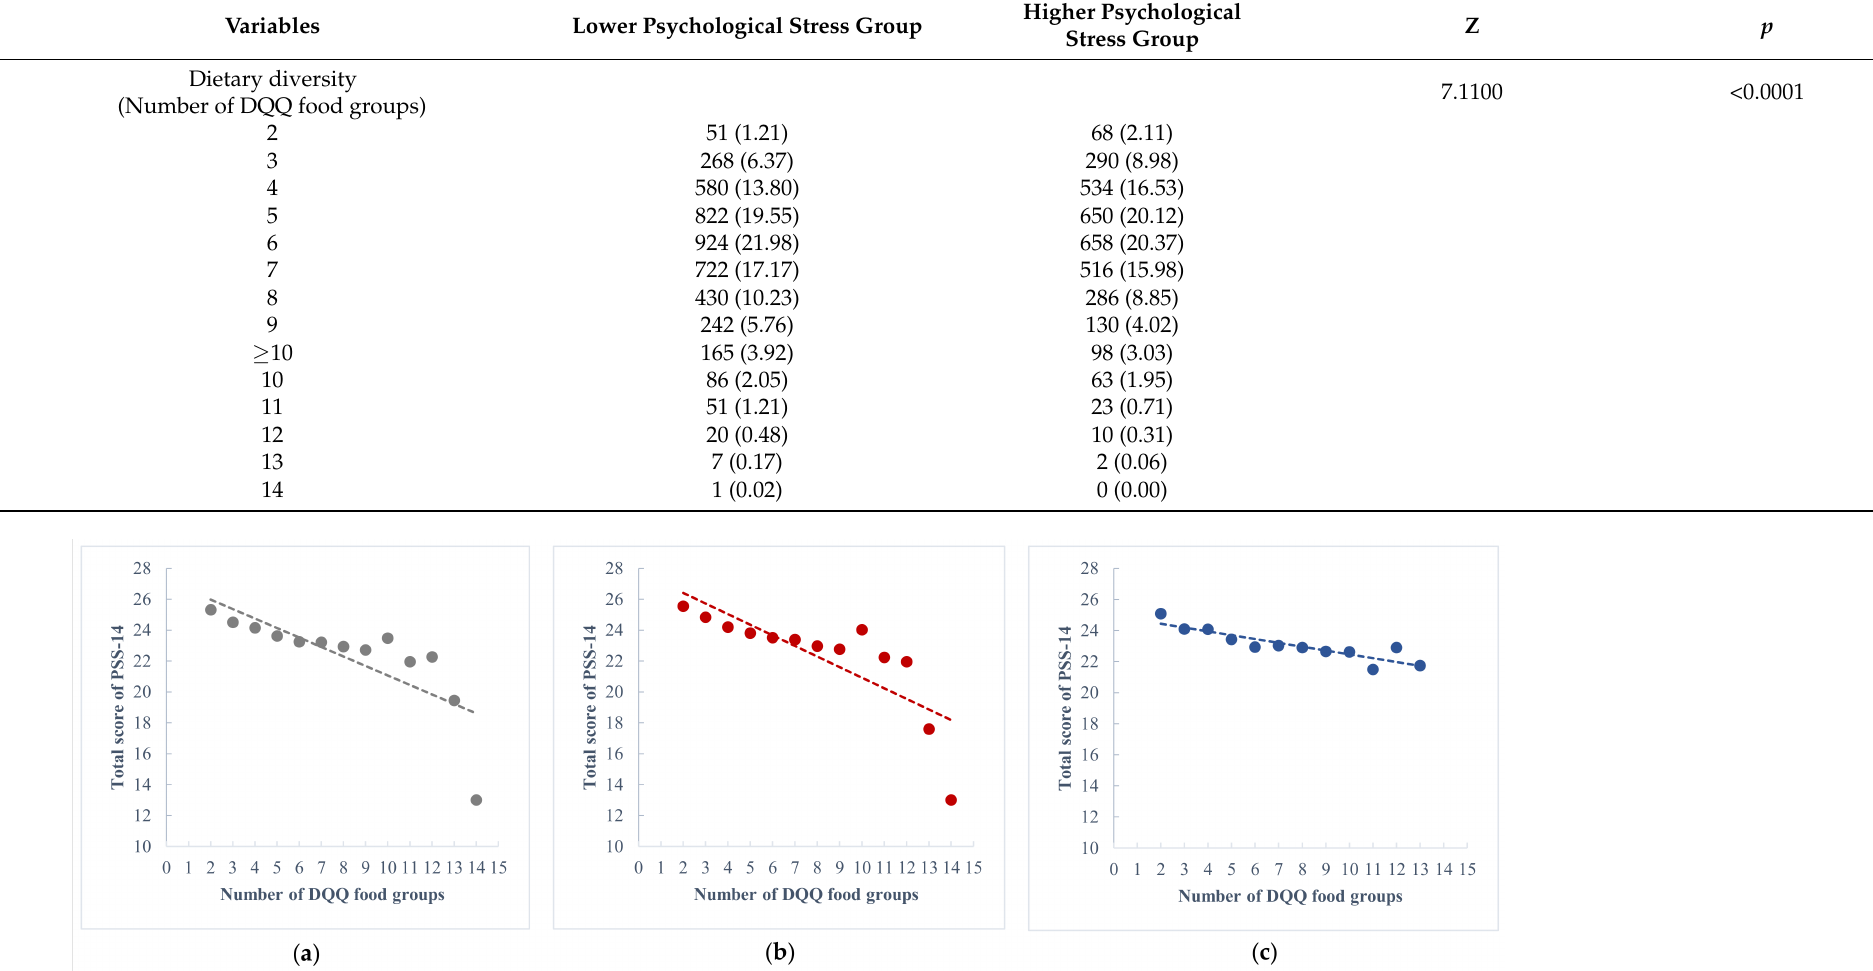
Figure 2. Trends in the relationship between psychological stress and dietary diversity. (a) The relationship for all participants; (b) The relationship for female participants; (c) The relationship for male